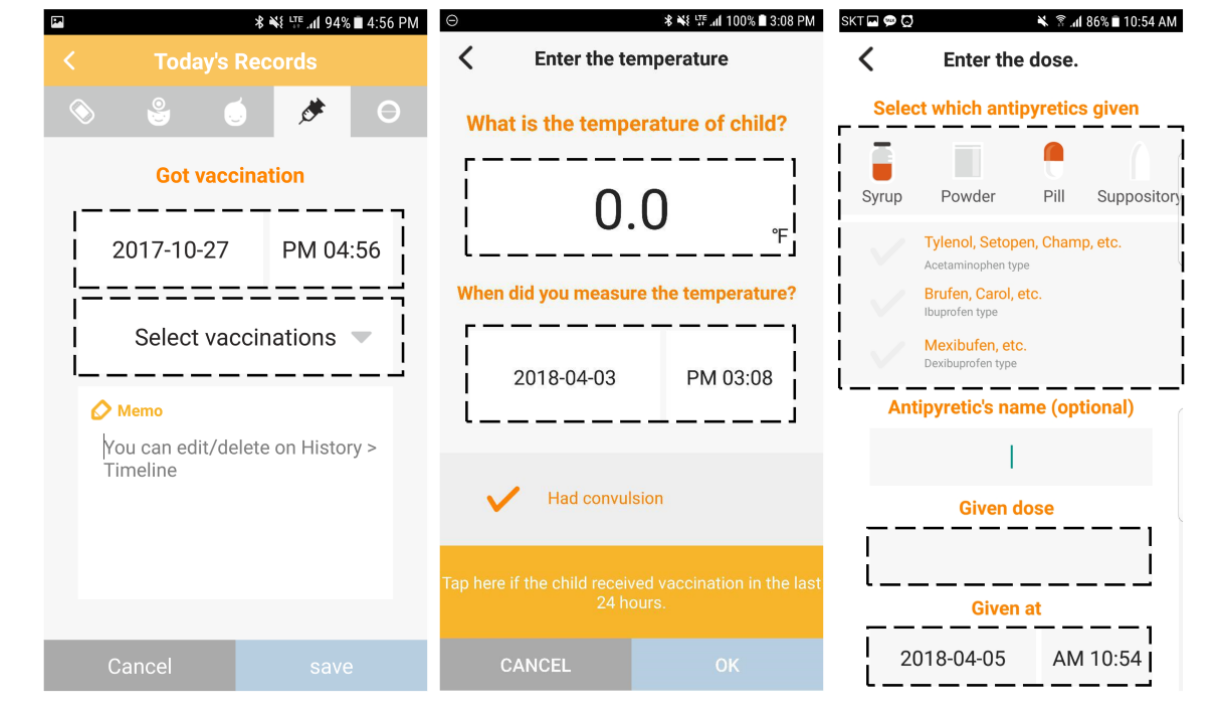
Figure 1. Screenshots of vaccination and fever response in the Fever Coach app. The left screen (“Today’s Records”), middle screen (“Enter the temperature”), and right screen (“Enter the dose”) have areas for user-input data. The functions corresponding to vaccination data, fever response, and antipyretic data in the three screens are indicated with dotted boxes. The original app showed Korean menu names; for international use, they have been translated into